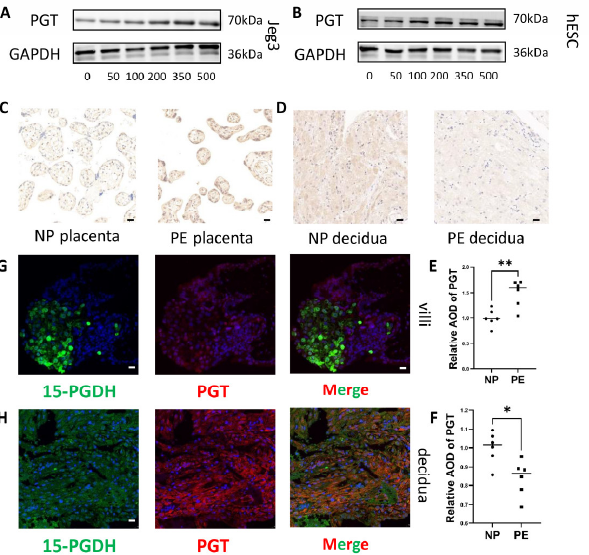
Figure 6. 15-PGDH inhibitor increased PGT expression and PGT differential expression in PE patients. ( A ) Western blot assays showed that PGT expression increased in Jeg3 cells when treated with concentration of SW033291. ( B ) Western blot assays show that PGT expression increased in hESCs treated with concentration of SW033291. ( C , E ) Immunohistochemical staining showed the relative quantification of PGT in the placenta of the PE and NP groups ( n = 6). Scale bar = 20 nm. ( D , F ) Immunohistochemical staining showed the relative quantification of PGT in the decidua of the PE and NP groups ( n = 6). Scale bar = 20 nm. Values are the mean ± SD. * p < 0.05; ** p < 0.01. Each experiment was independently performed three times. ( G , H ) 15-PGDH and PGT, both located in trophoblasts and DSCs, were identified by immunofluorescence; red: PGT; green: 15-PGDH. G:Scale bar = 20 nm; H: Scale bar = 50 nm. The experiment was repeated 3 times